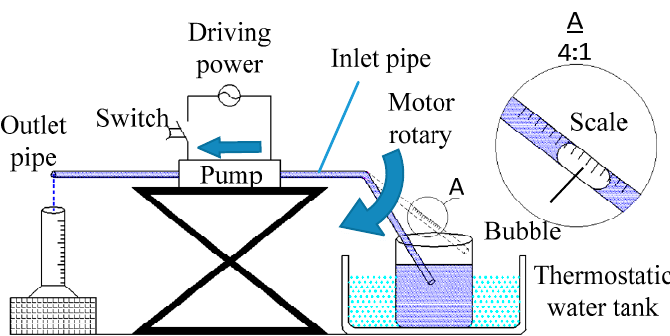
Figure 8. Micro-pump air block experiment device.